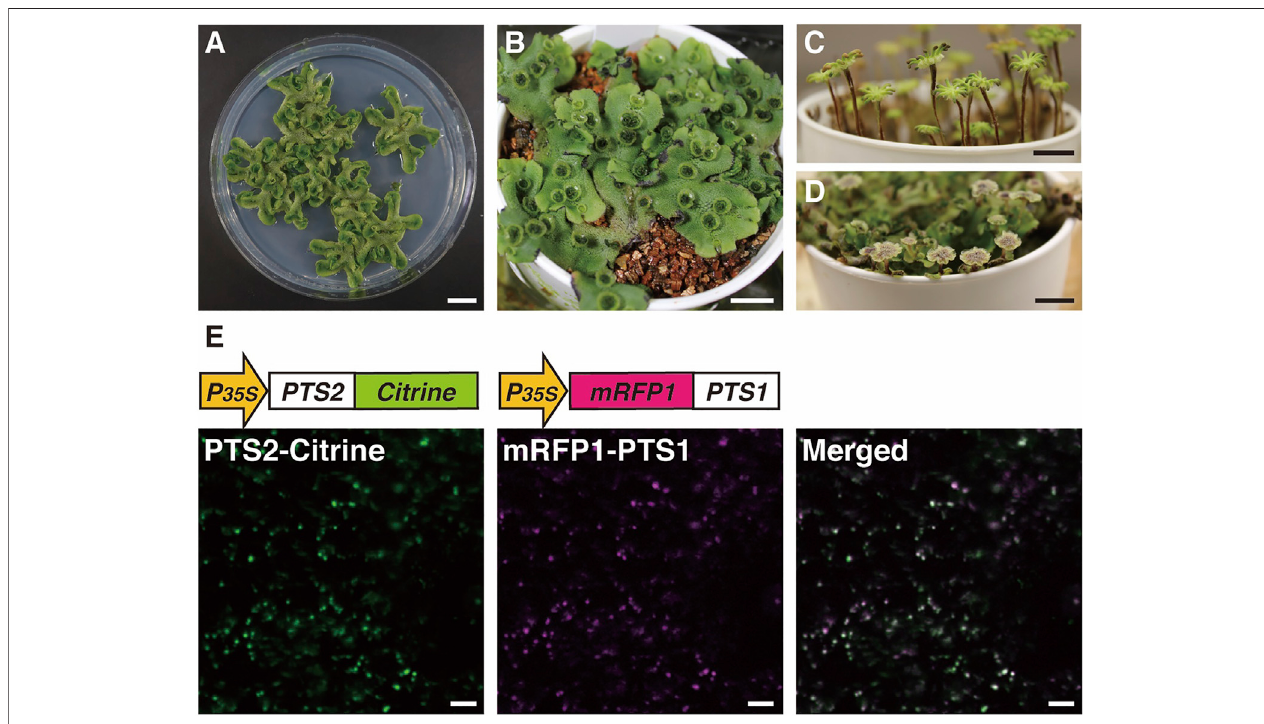
FIGURE5| Imagesof M.polymorpha andvisualizationofperoxisomesusingCitrine-andmRFP1-fusedproteins.Vegetativehaploidlifeform(thallus) onagarplate (A) and vermiculite (B) (Shimamura, 2016). Female (C) and male (D) sexual organs from the haploid thallus of a female plant or a male plant, respectively (Chiyoda et al., 2008; Inoue et al., 2019). Bars, 1 cm. (E) Fluorescence in peroxisomes was observed in thallus epidermal cells expressing both pro35S:PTS2-Citrine and pro35S: mRFP1-PTS1 genes (Mano et al., 2018). Bars, 10 μ m.